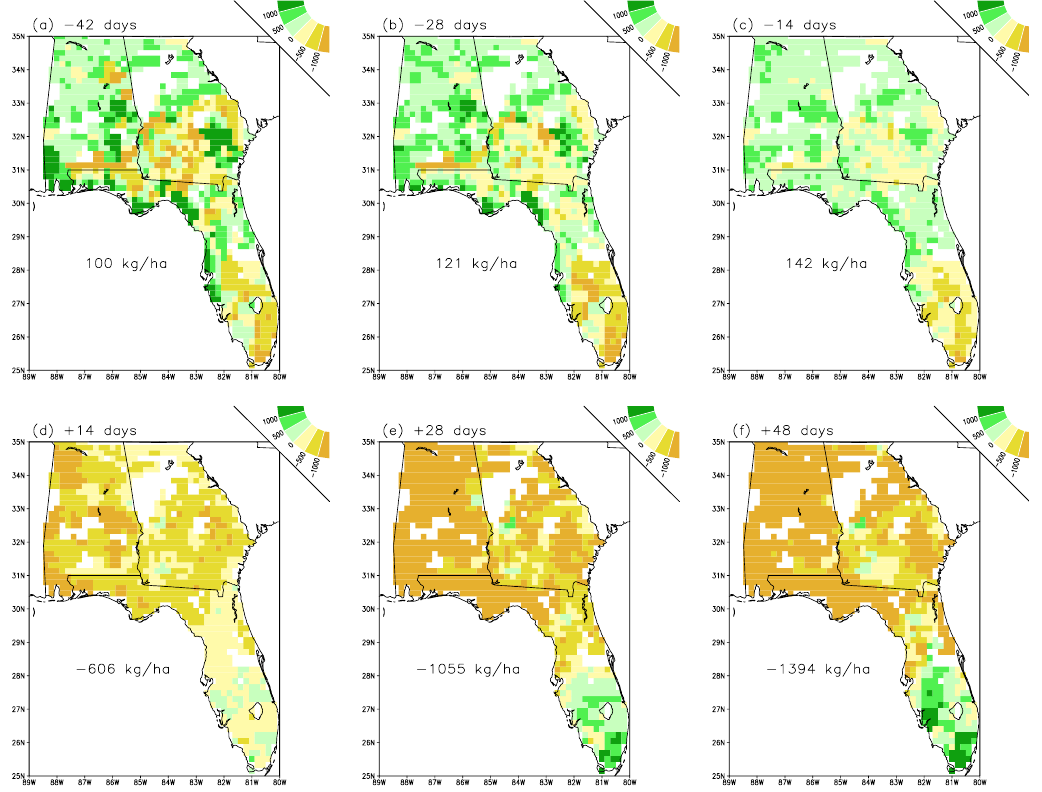
Figure 7. Simulated NARCCAP C3 regional-model-driven future maize dry matter yield di ff erences between six di ff erent planning dates ( ± 14, ± 28, and ± 42 days) and the control planting date (1 April) under rainfed conditions. Unit is of kg ha − 1 . Area averaged values are shown.